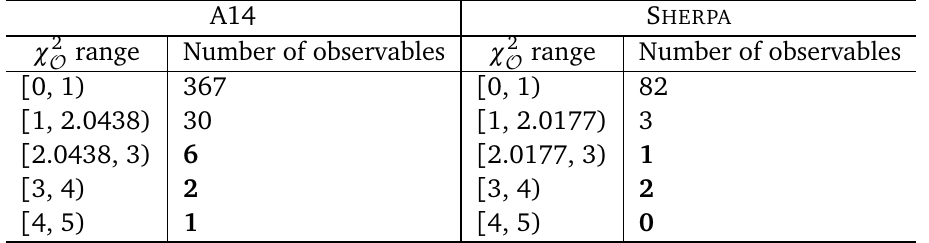
Table 4: Distribution of the χ 2 values for A14 (left) and S HERPA (right). 2.0438 and O 2.0177 correspond to the values where the Z-score equals 3 (see Section 3.1).